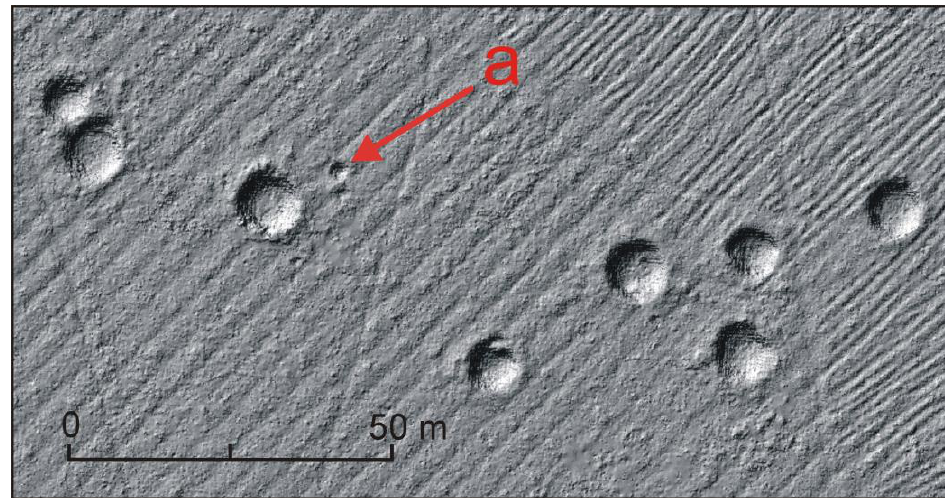
Fig. 3. Crater caused by UXB (a) between craters from bomb explosions (figure prepared by the